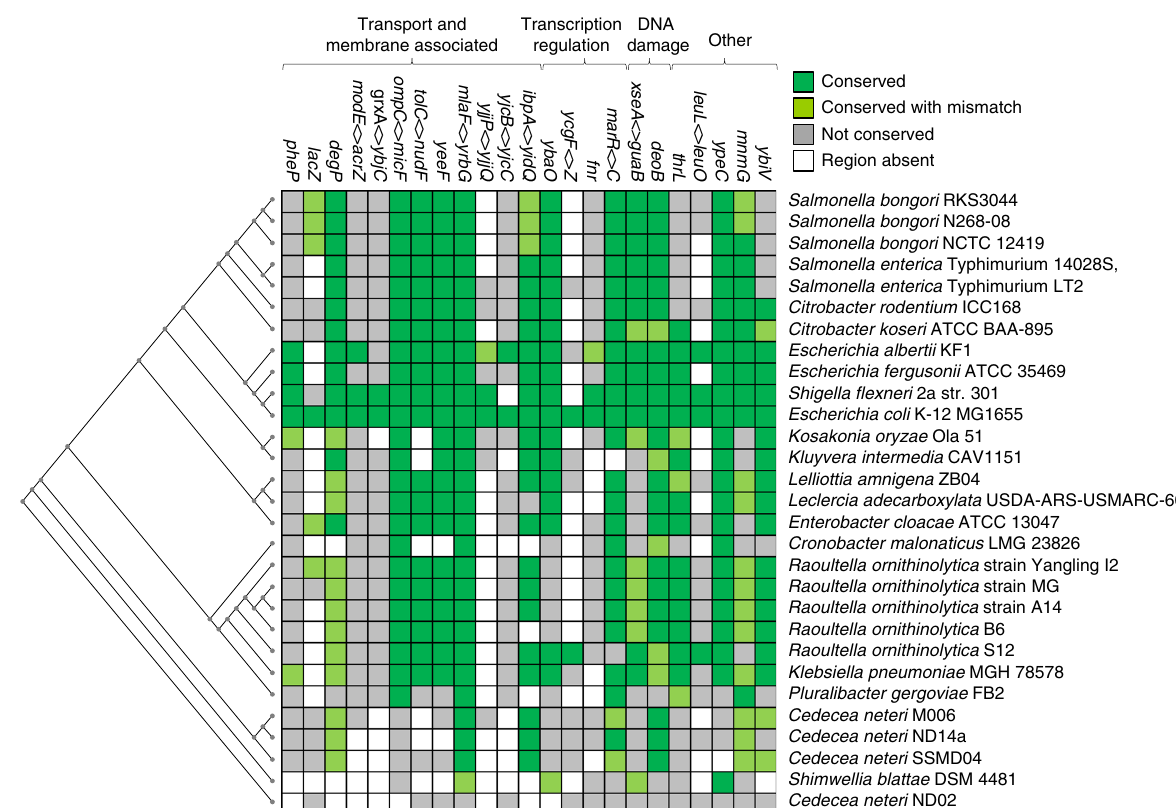
Fig. 4 Phylogentic footprinting of the MarA regulon. The heatmap illustrates conservation of marboxes identi fi ed by ChIP-seq ( x -axis) in the genomes of different enteric bacteria ( y -axis). Dark green indicates conservation of a marbox with a maximum of one mismatch and light green indicates a maximum of two mismatches. Grey indicates that the intragenic region was identi fi ed but the marbox was poorly conserved or absent. Open boxes represent intergenic regions that were not identi fi ed in that genome. The evolutionary relationship between the different organisms, determined on the basis of the polA gene sequence, is indicated by a